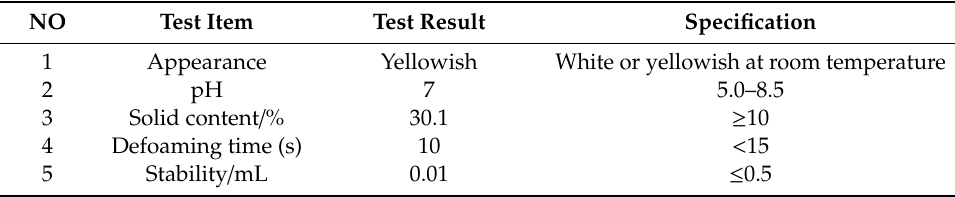
Table 4. Test results of the technical index of silicone